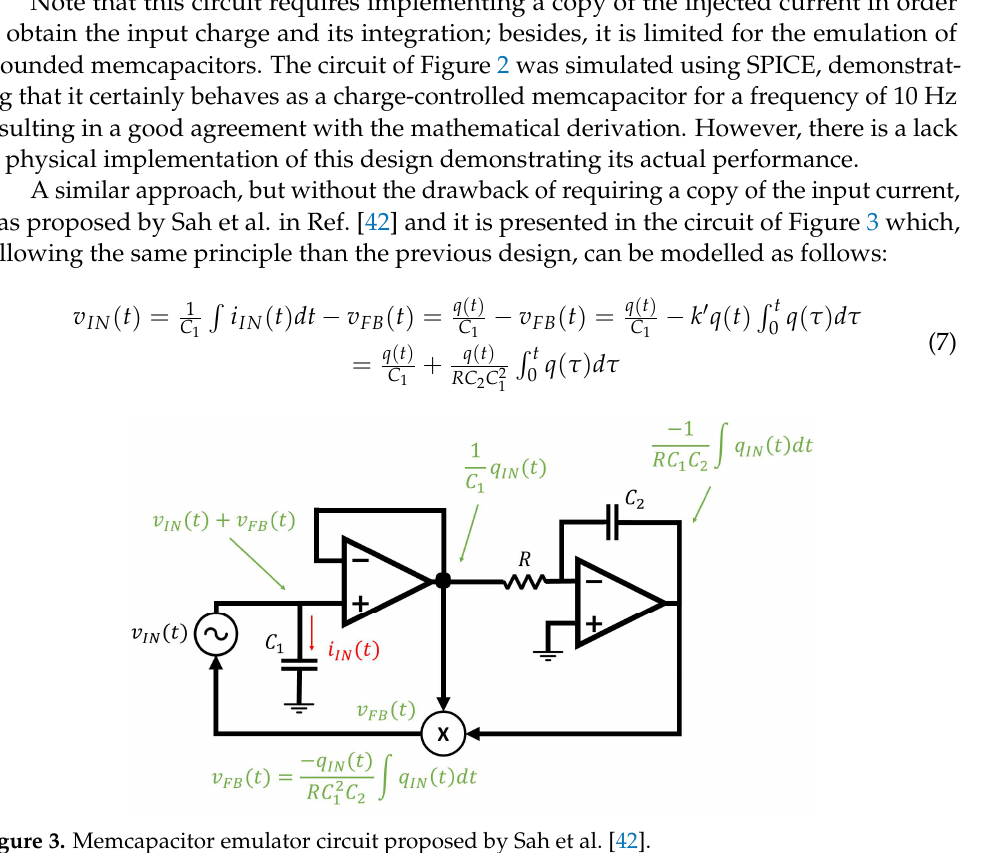
Figure 3. Memcapacitor emulator circuit proposed by Sah et al.